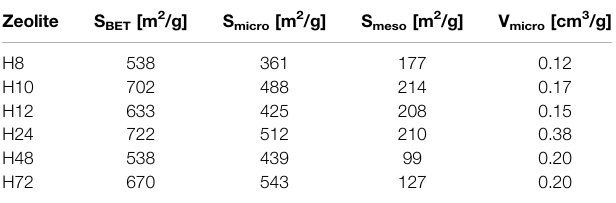
TABLE 2 | Textural properties of as-synthesized HBEA zeolites at different hydrothermal times.